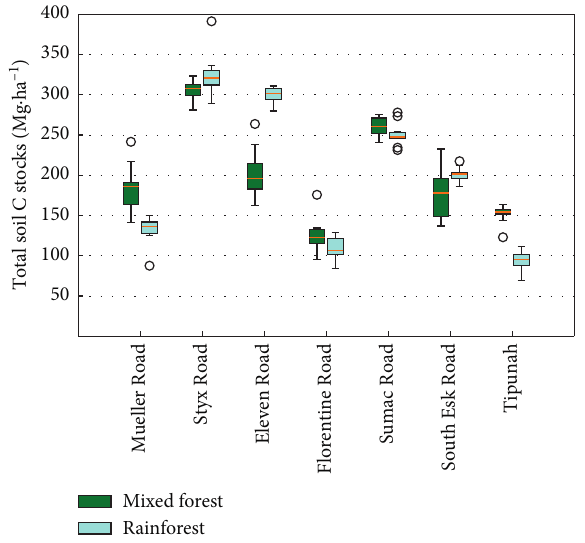
Figure 3: Total C held in soils to 1m depth or to a rock contact at shallower depth (Mueller Road and Tipunah sites). Green shad- ing � mixed forest; blue shading � rainforest. The bars indicate 1.5x the interquartile range. Open circles indicate values outside this range.